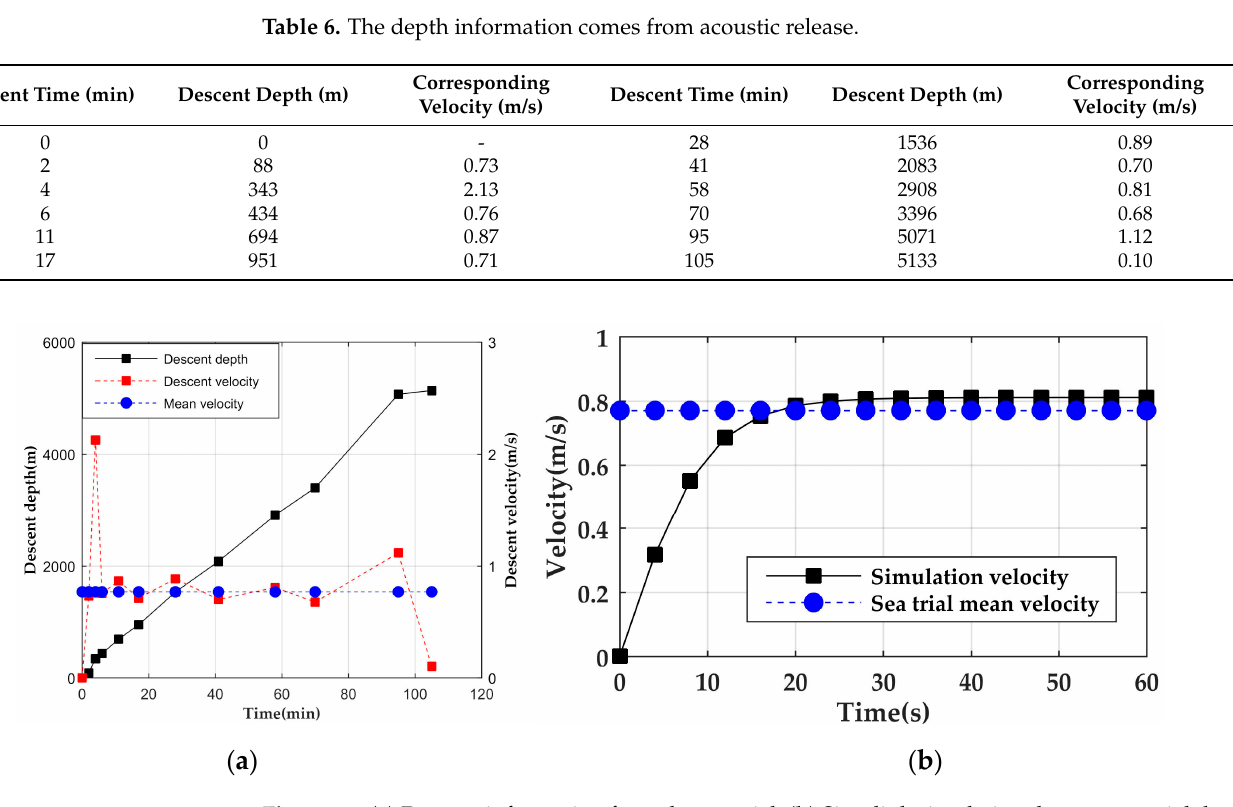
Figure 10. ( a ) Descent information from the sea trial; ( b ) Simulink simulation data vs. sea trial data.